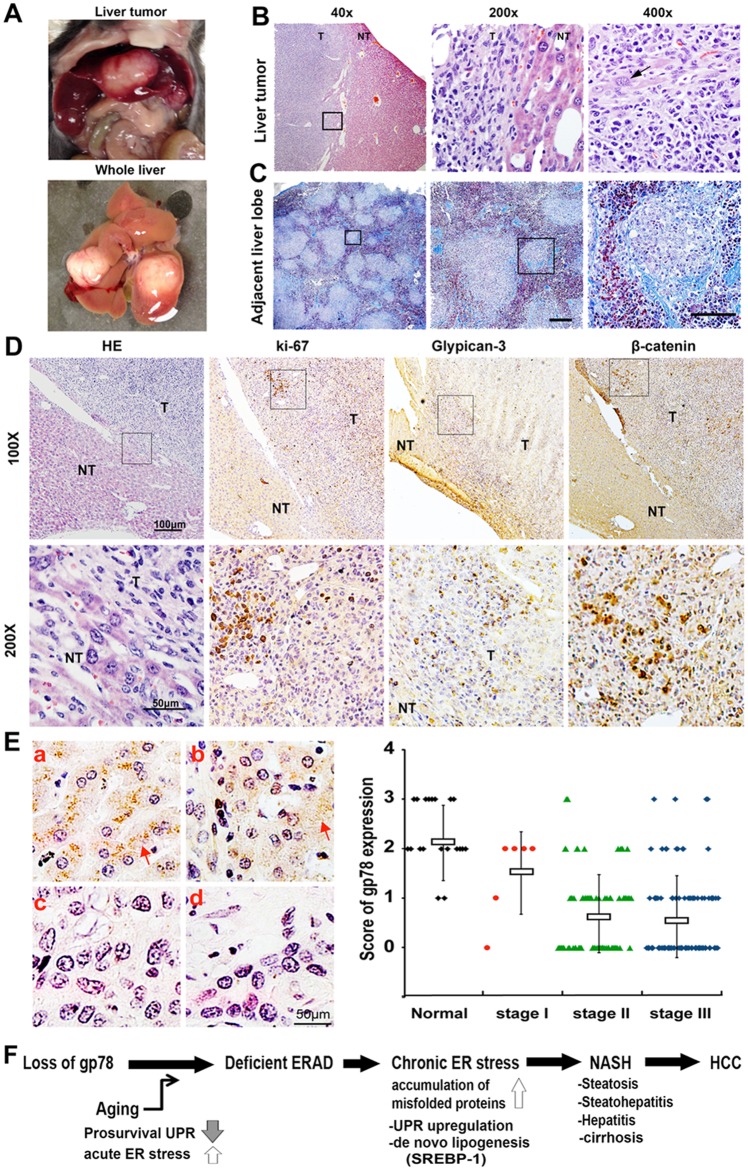
Gp78-KO mice spontaneously develop cirrhosis and liver cancer.(A) Photography in gp78-KO mouse harboring two liver tumors. (B) H&E stain. Arrow indicates characteristic of hepatic cells and multiple nucleoli per nucleus. (C) Cirrhosis in gp78 liver. Trichrome stain in another adjacent lobe of liver bearing tumor. Blue color indicates fibrosis. (D) Serial sections of gp78-KO liver harboring tumor (T) and adjacent normal liver tissue (NT) were subjected to IHC analysis with antibodies specific to ki-67, proliferation marker; glypican-3, human HCC marker; β-catenin, aberrant Wnt signaling marker respectively. (E) Gp78 down regulation in IHC array of human HCC. Duplicated specimens per a patient were stained with anti-gp78 antibody. A, normal liver (> 50% stain); b, stage I (< 50% stain); c, stage II (<10% stain); d, stage III (0% stain). Graph represents the level of gp78 expression according to tumor grade (normal liver, n of patient = 10; stage I, n = 3; stage II, n = 40; stage III, n = 46). A score was calculated (0, negative; 1, < 10%; 2, 10% to 50%; 3, > 50% positive stained). (F) Hypothetic mechanism underlying NASH and HCC pathogenesis in gp78-KO mice. Gp78-mediated ERAD efficiency gives rise to hypersensitivity response to acute ER stress following aging, leading to chronic ER stress in which misfolded proteins are persistent and induce Chop-mediated apoptosis, SREBP-mediated lipogenesis, ultimately leading to inflammation, NASH, and cancer.